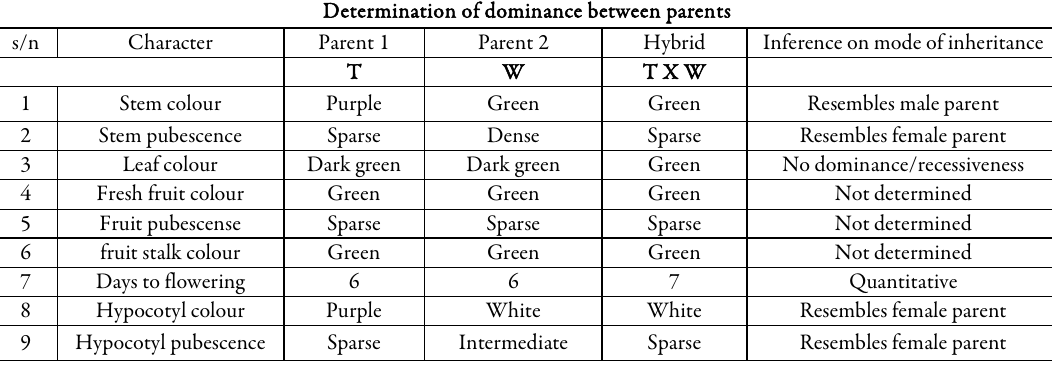
Table 11. Comparison of T and